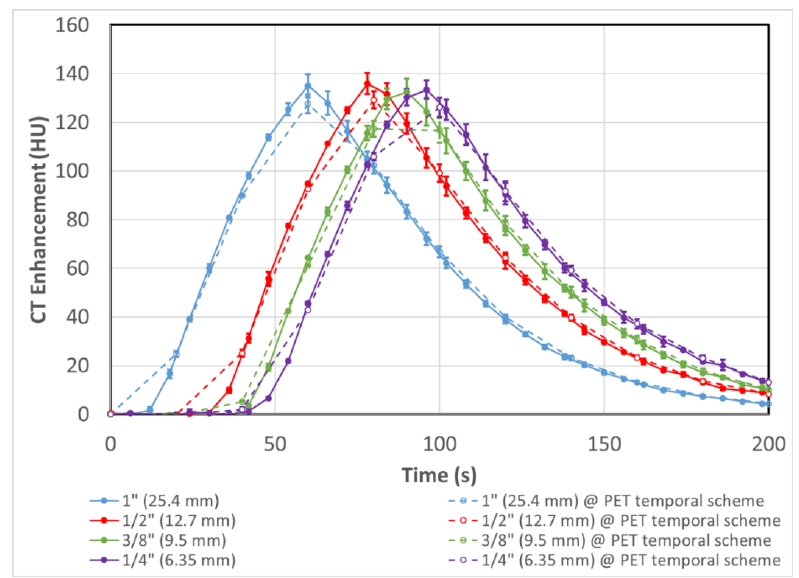
Figure 5. Solid lines are input function shape and intensity of the 4 tubes of decreasing internal diameter as assessed with DCE-CT. As the contrast passes through tubes of decreasing size the velocity of the fluid increases but the flow rate remains constant which produces a set of 4 reference curves with equal intensity, shape and AUC. Dashed lines are curves with averaging done over 20 s on the corresponding solid lines at the same sampling time points as the dPET scan (described in Section 3.2). Error bars represent the experimental range of replicate results (n = 2).